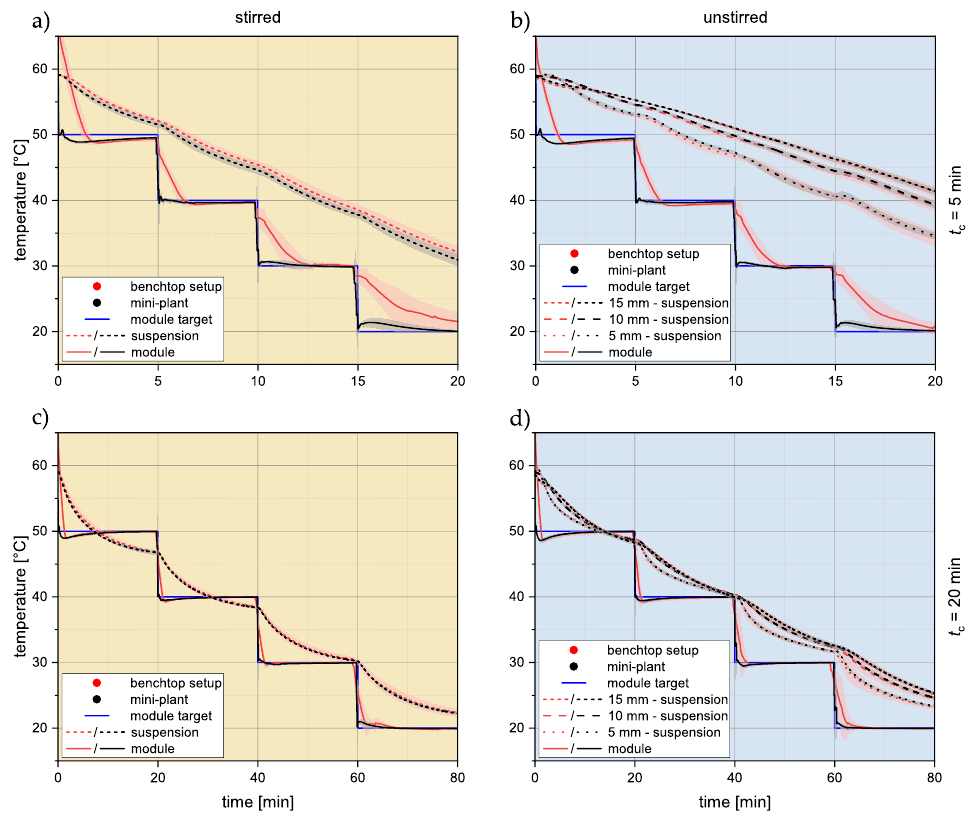
Figure 4. Temperature profiles of the suspension on the mini-plant (black) and benchtop setup (red): stirred and t c = 5 min in ( a ); unstirred and t c = 5 min in ( b ); stirred and t c = 20 min in ( c ); unstirred and t c = 20 min in ( d ). Each of the experiments was performed in a fourfold manner. The standard deviation is shown as a transparent tube around the corresponding